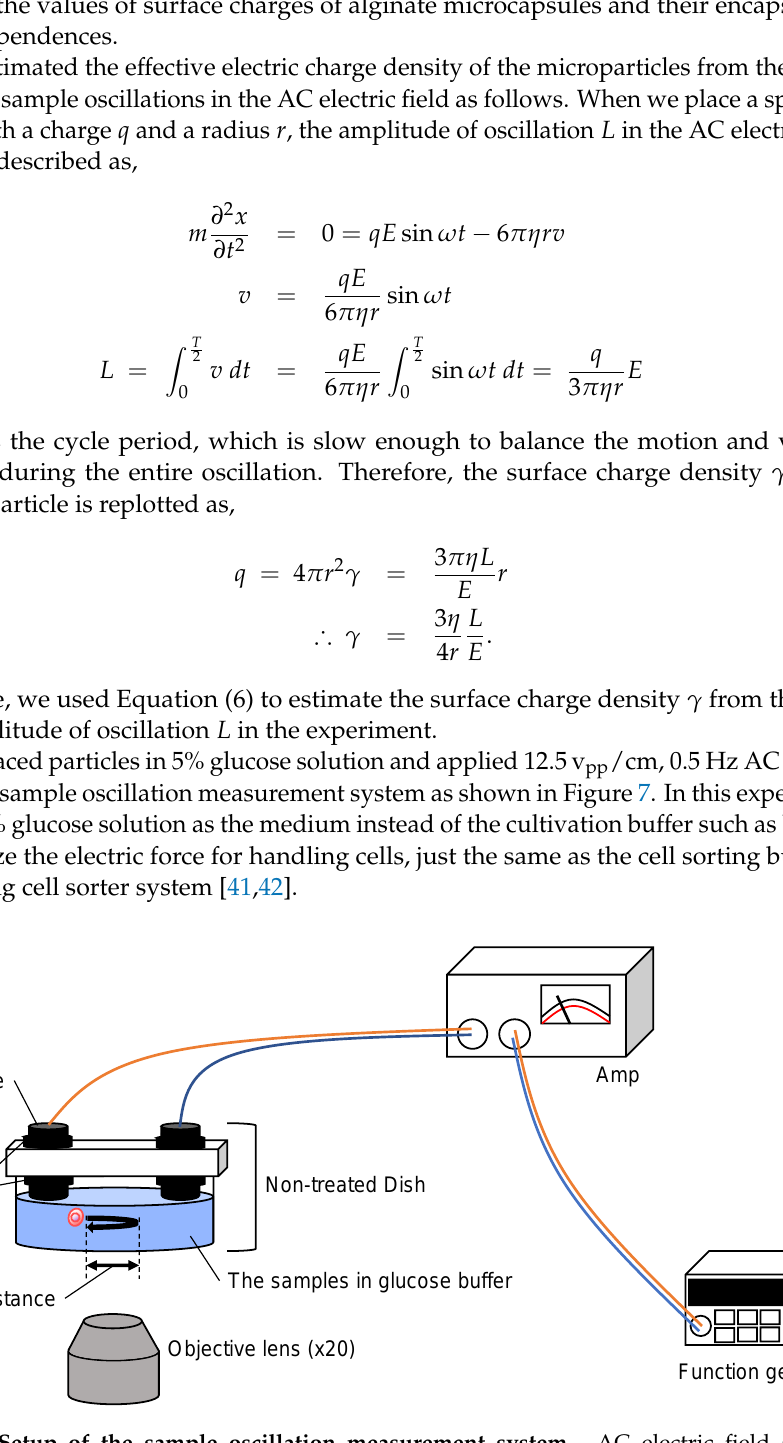
Figure 7. Setup of the sample oscillation measurement system. AC electric field (0.5 Hz, 0.42~12.5 v/cm) was applied between the two carbon rod electrodes from the function generator and the amplifier. The oscillation of samples was measured with optical